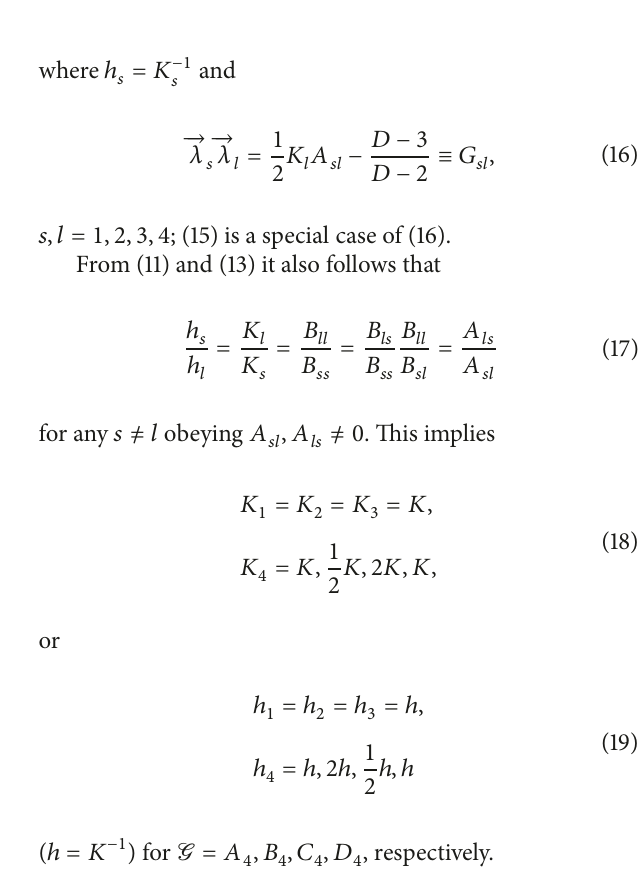
Figure 1: The Dynkin diagrams for the Lie algebras 𝐴 4 , 𝐵 4 , 𝐶 4 , and 𝐷 4 ,